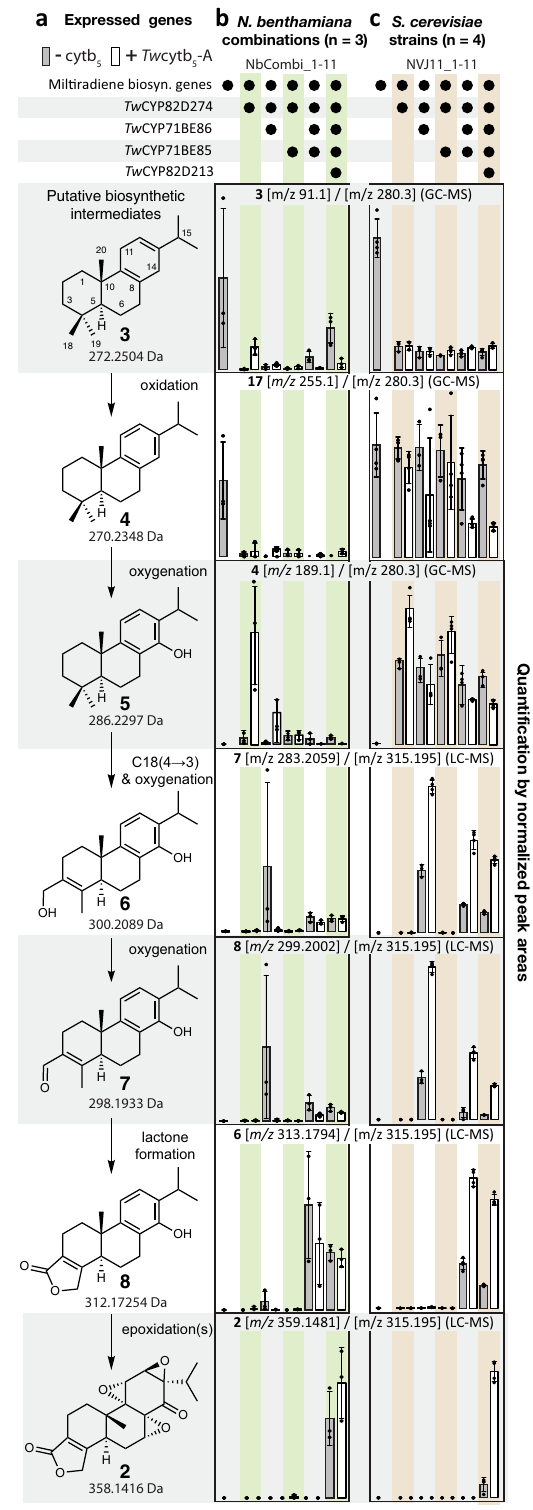
Fig.2|Biosynthesisoftriptonidefrommiltiradiene.a Heterologouslyexpressed genes constituting the minimal set of biosynthetic components required for het- erologous triptonide biosynthesis. b quantity (bars) of putative key intermediates in the biosynthetic pathway of triptonide (right), when established in vivo via heterologousgeneexpressionin N.benthamian a. c ,quanti fi cationofintermediates from engineered S. cerevisiae (strains listed in Supplementary Table 28). The combination of genes co-expressed with the miltiradiene biosynthetic genes is indicated by black dots. Quanti fi cation was based on peak areas of signature m/z valuesfortheputative intermediates,normalizedto thepeakareaofsignature m/z values for the internal standard (IS) used in the GC-MS (compounds 3 – 5 ) and LC- qTOF-MS(compounds 6 – 8 & 2 ). Signature m/z valuesaredenoted in the header of each bar diagram. Bars represent the average of n =3 [ N. benthamiana ] or n =4 [ S. cerevisiae ] biological replicates, with error bars representing standard error of the mean (SEM). Values from each replicate is marked by black diamond squares. White-andgrey fi llcolorofthebarsdistinguishescompoundquantityinrelationto no expression (grey) or co-expression (white) of Tw cyt b 5 -A , respectively. Mass tolerance was ±0.1 m / z for GC-MS and ±0.005 m / z for LC-qTOF-MS for signature m / z values. Source data are provided as a Source Data fi